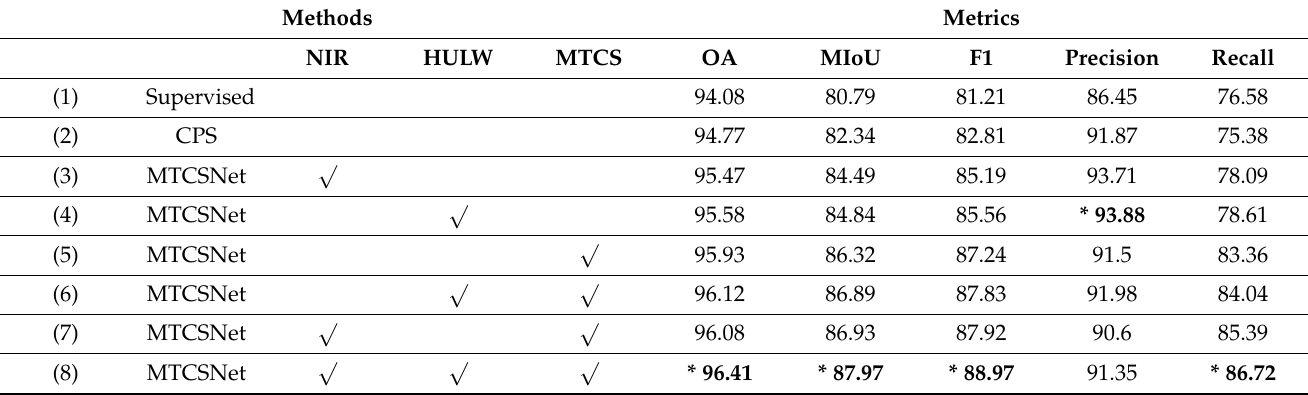
Table 3. Quantitative performance of ablation experiments on the SPARCS